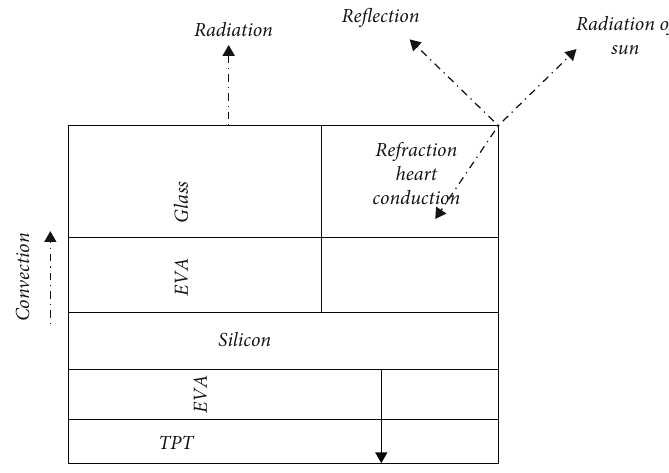
Figure 4: Internal structure of PV cell. Table 1: Properties of physical material.